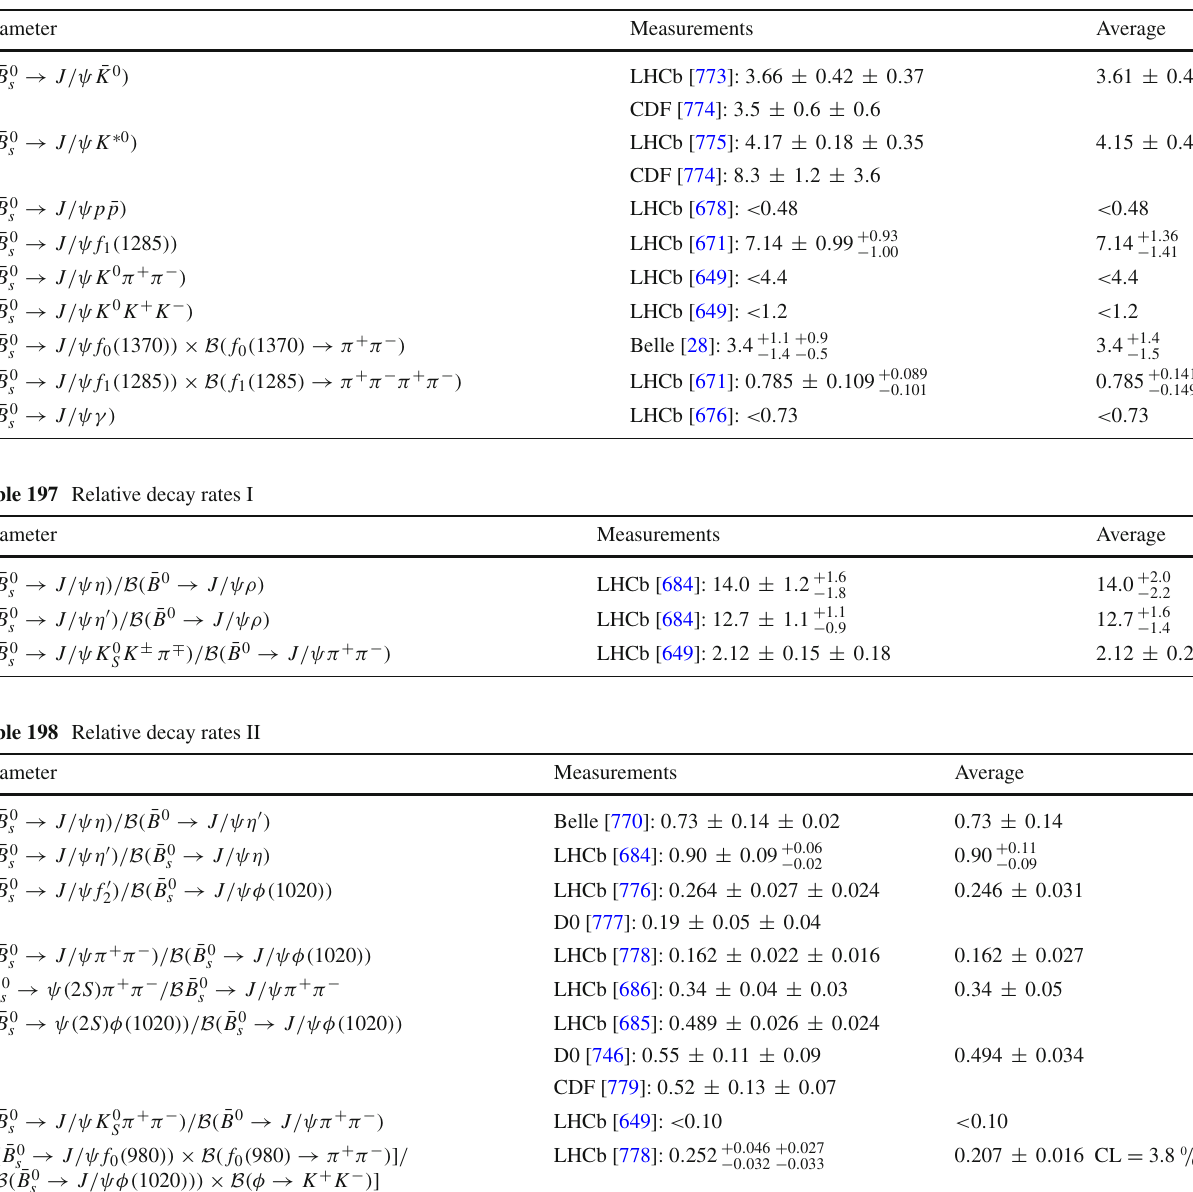
Table 196 Absolute decay rates II [ 10 − 5